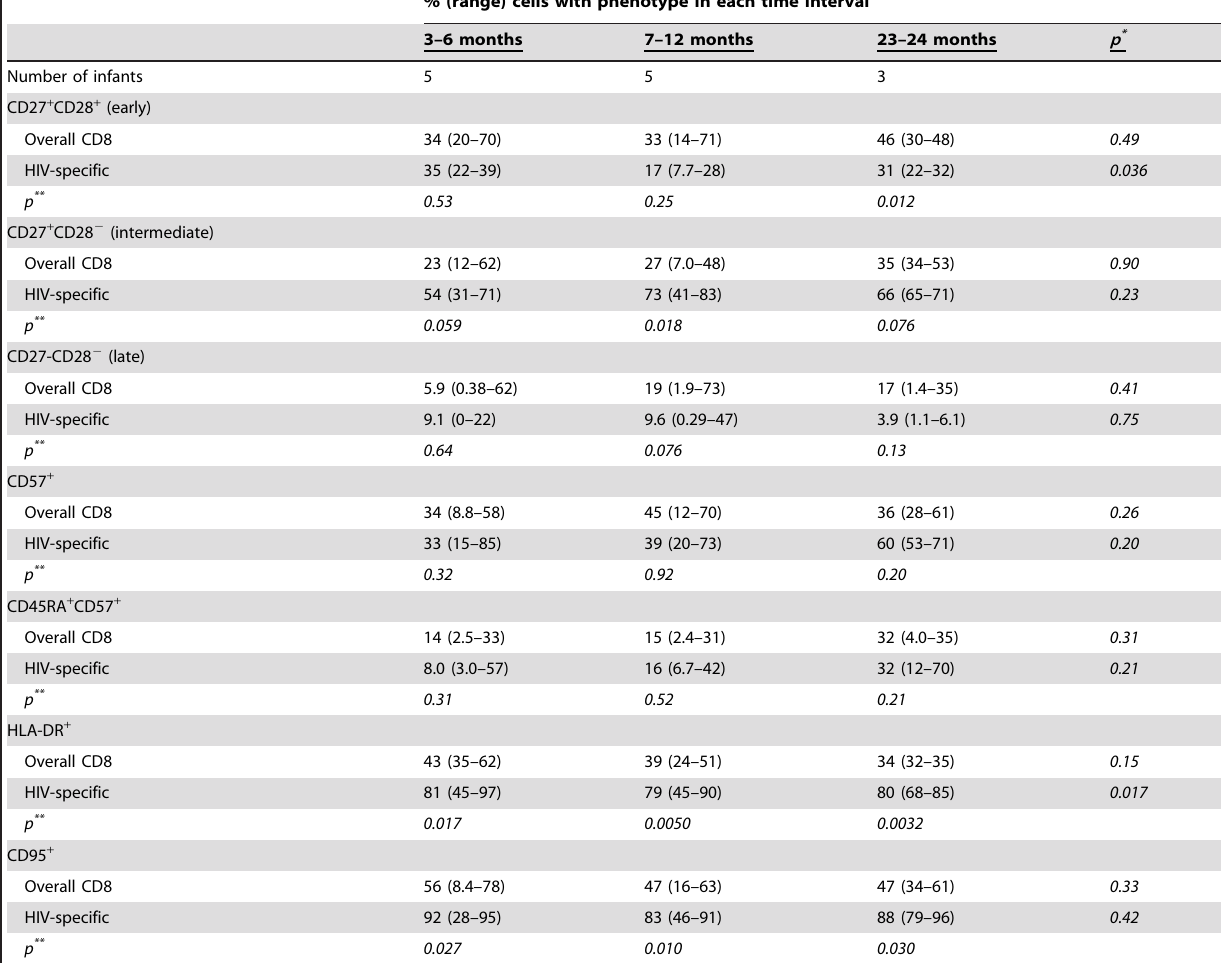
% (range) cells with phenotype in each time